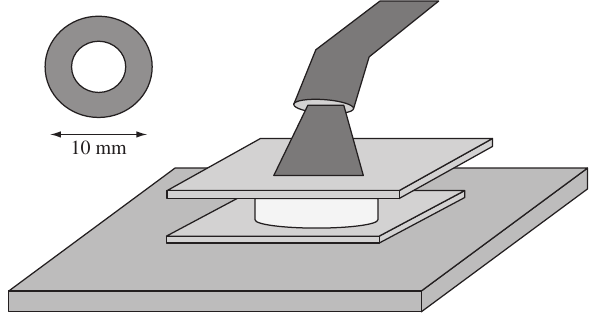
Figure 1. Photopolymerization of